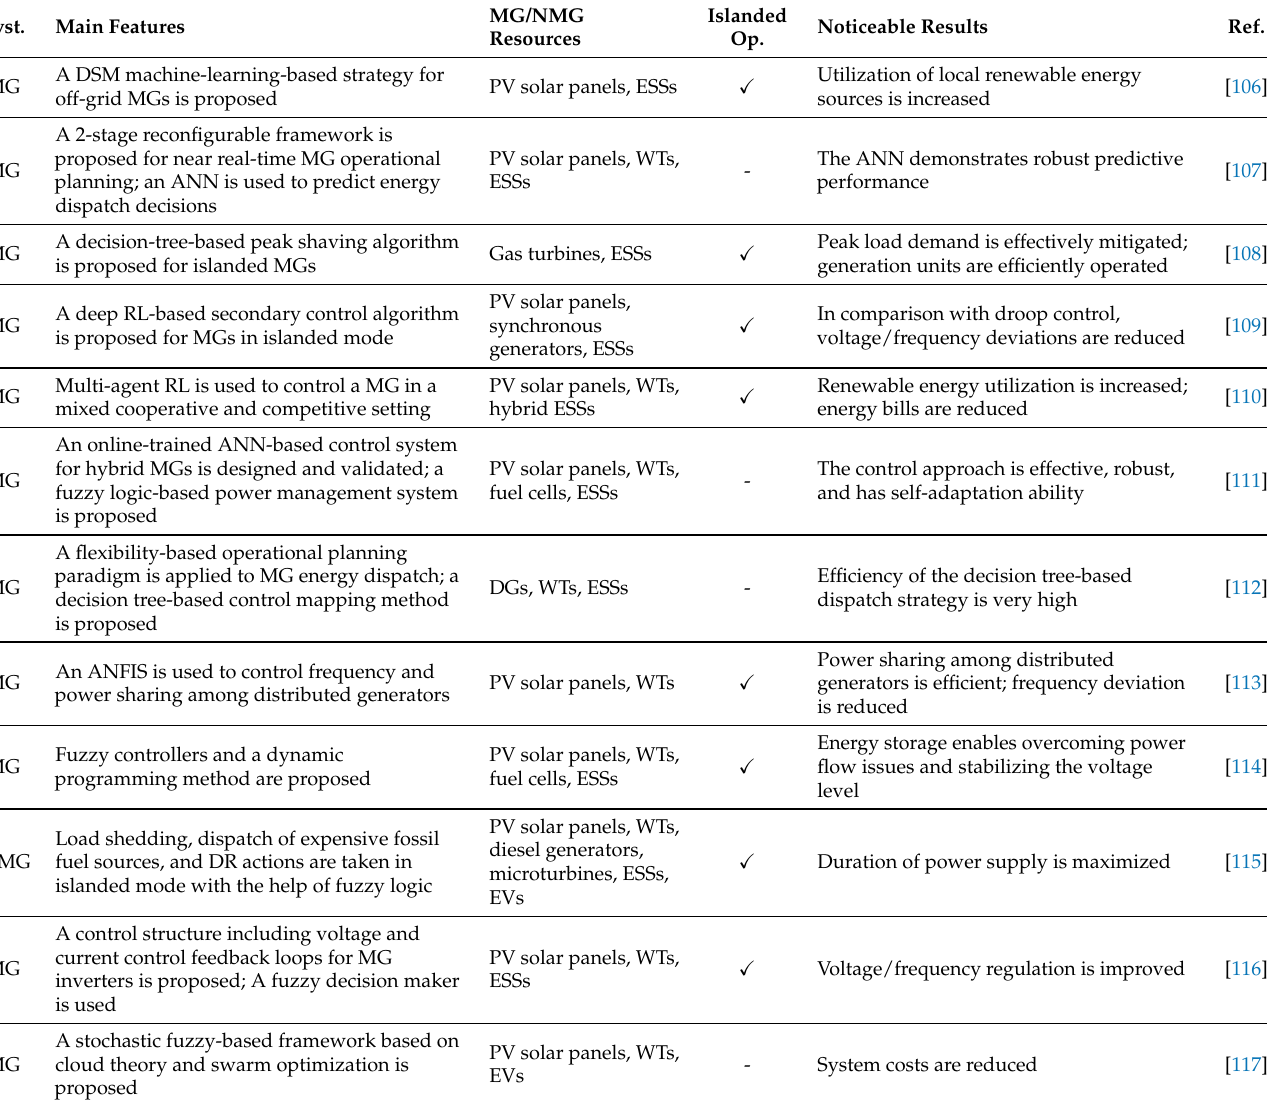
Table 8. A focus on papers dealing with artificial intelligence (AI) methods for MG/NMG manage- ment. ANFIS stands for adaptive neuro-fuzzy inference system. ANN stands for artificial neural network. DG stands for distributed generator. DR stands for demand response. DSM stands for demand side management. ESS stands for energy storage system. MG stands for microgrid. NMG stands for netwoked microgrid. RL stands for reinforcement learning. WT stands for wind turbine.